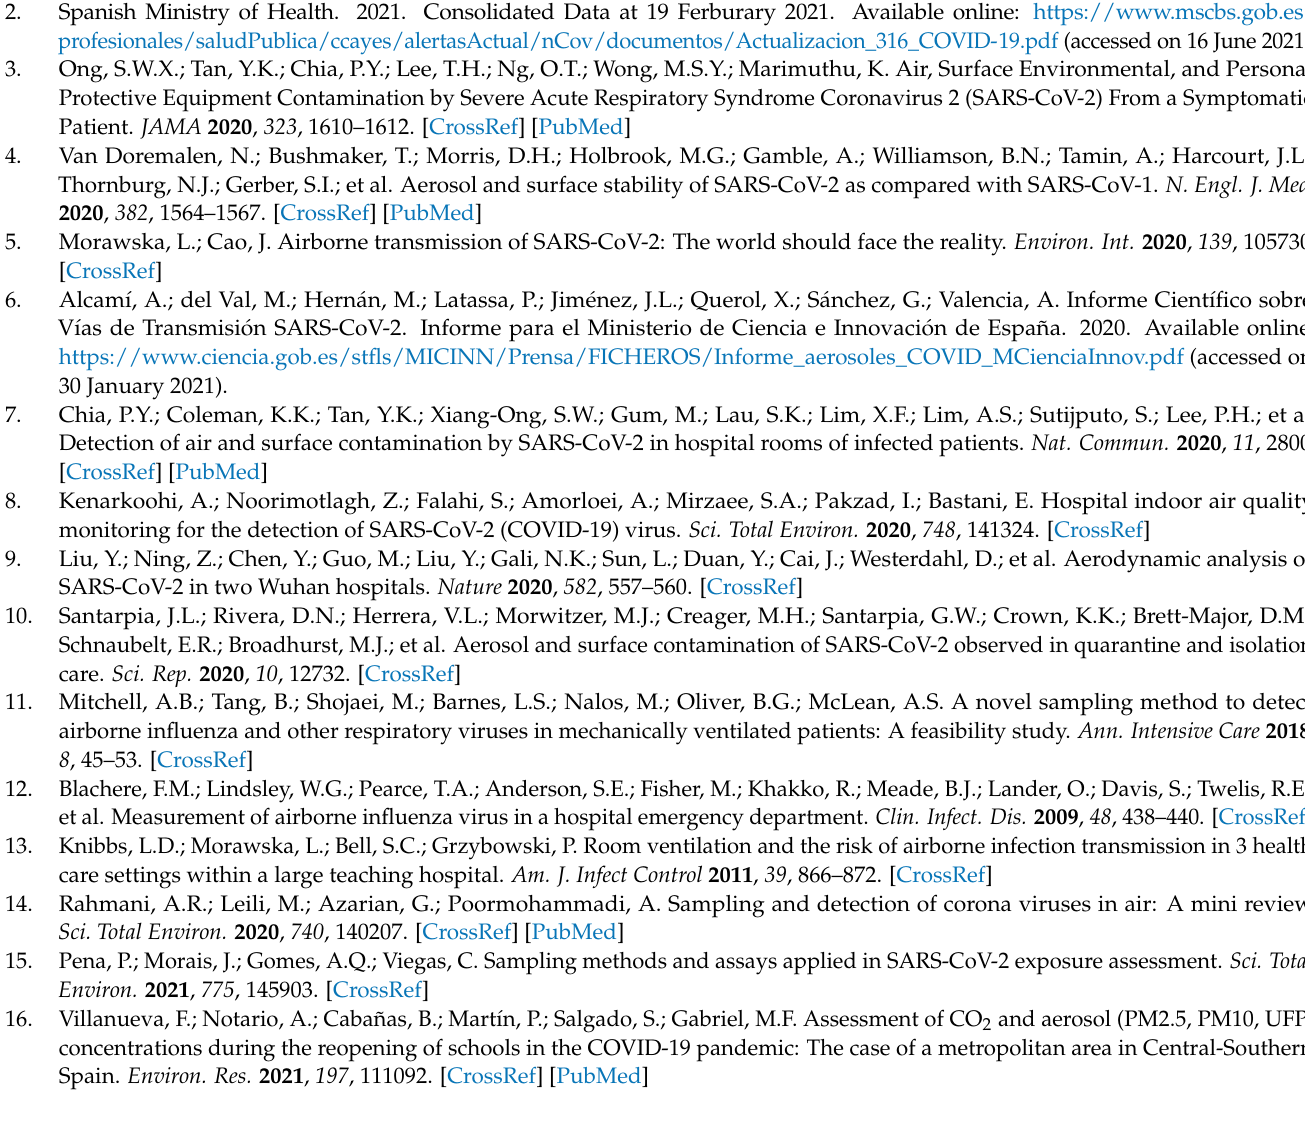
Figure S16, VOC concentrations (ppm) in the hall; Figure S17, VOC concentrations (ppm) in the waiting room; Figure S18, temperature ( ◦ C) in the hall; Figure S19, temperature ( ◦ C) in the waiting room; Figure S20, temperature ( ◦ C) in the doctor’s consultation; Figure S21, relative humidity (%) in the hall; Figure S22, relative humidity (%) in the waiting room; Figure S23, relative humidity (%) in the doctor’s